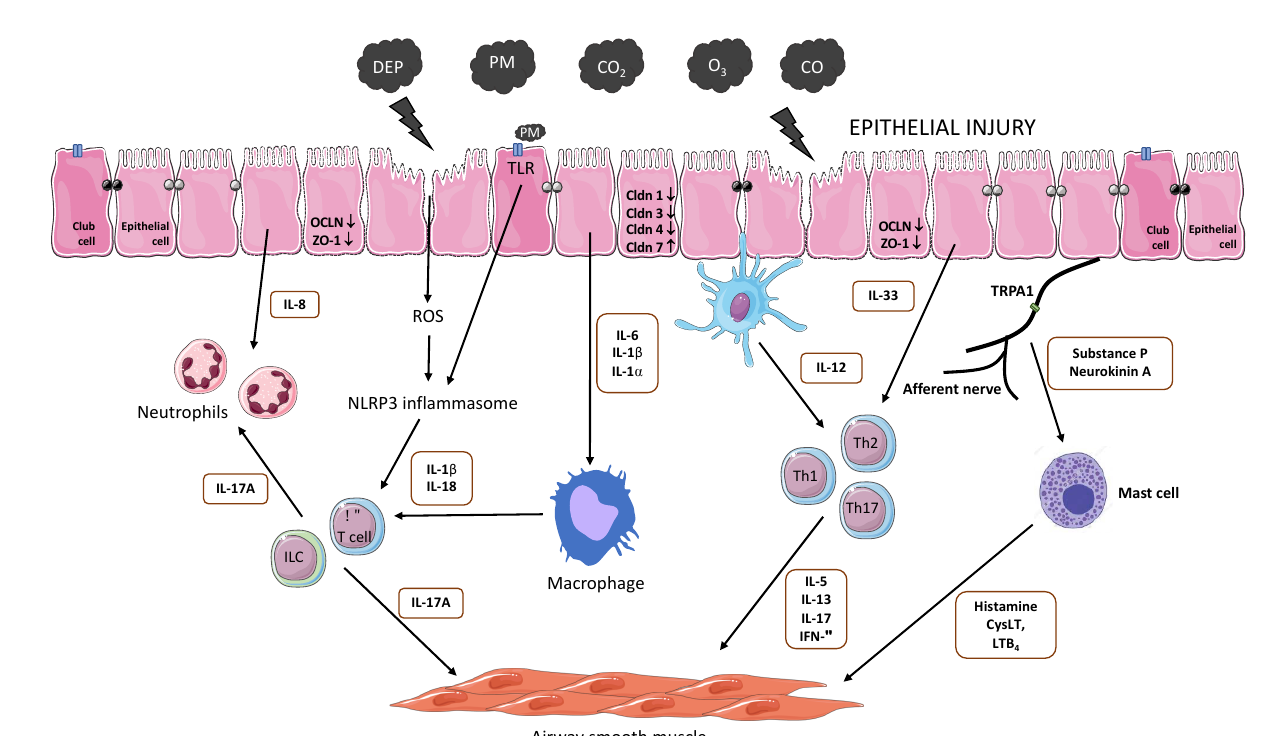
Figure 2. Overview of the inflammatory processes induced by air pollutants in the airways. Air pollutants such as diesel exhaust particles (DEP), particulate matter (PM), carbon dioxide (CO 2 ), ozone (O 3 ) and carbon monoxide (CO), will induce epithelial injury leading to a decrease in tight junctions occludin (OCLN), zonula occludens 1 (ZO-1) and claudin (Cldn) 1, 3 and 4. In addition, pro-inflammatory cytokines IL-6, IL-1β, IL-1α and IL-8 and alarmin IL-33 will be released after epithelial injury. These cytokines will activate neutrophils and macrophages in the airways which can lead to bronchoconstriction. PM can also activate the epithelial cells via binding to toll like receptor (TLR) 2 or 4 leading to the activation of the NF-κB signaling pathway and the NLRP3 inflammasome. Air pollutants will also generate reactive oxygen species (ROS) which will activate innate lymphoid cells (ILC) and γδ T cells via the NLRP3 inflammasome. Reactive oxygen species can also activate transient receptor potential cation channel A1 (TRPA1) inducing neurogenic inflammation and activating mast cells resulting to airway smooth muscle contraction. Dendritic cells will present antigens from the air pollutants to T-lymphocytes and depending on the costimulatory molecules, a different subset of T cells (Th1, Th2 or Th17 cells) will be activated further increasing the inflammatory mediators and bronchoconstriction.